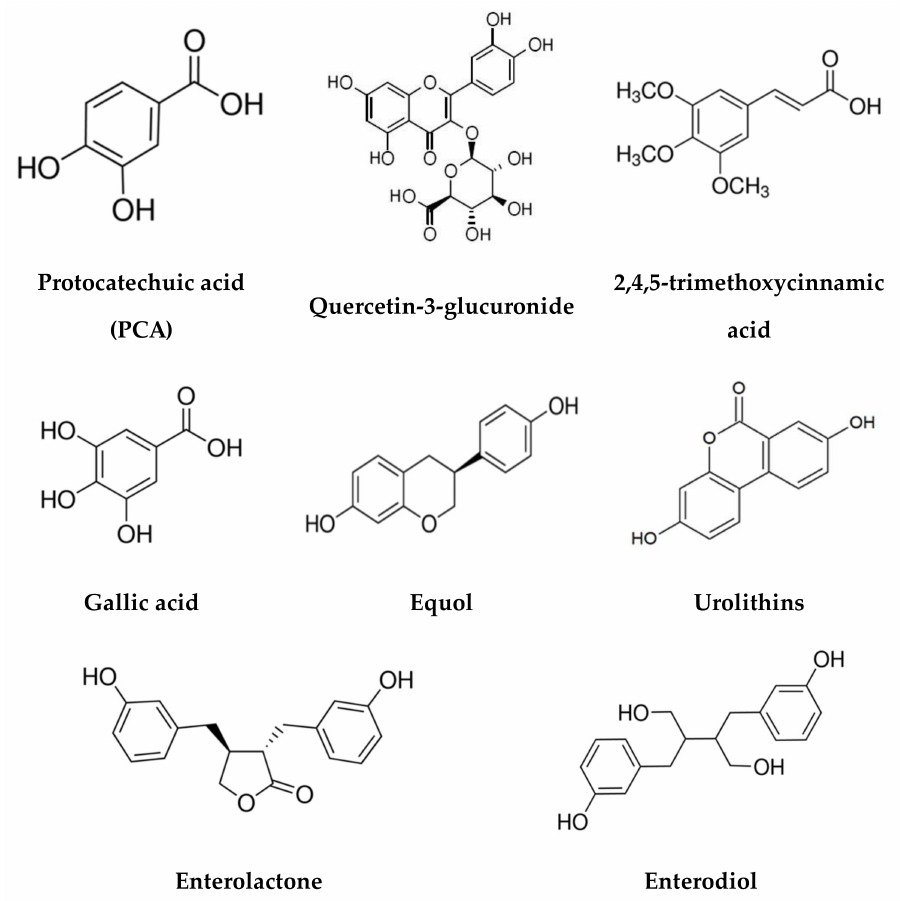
Figure 2. Chemical structures of bioactive like polyphenolic